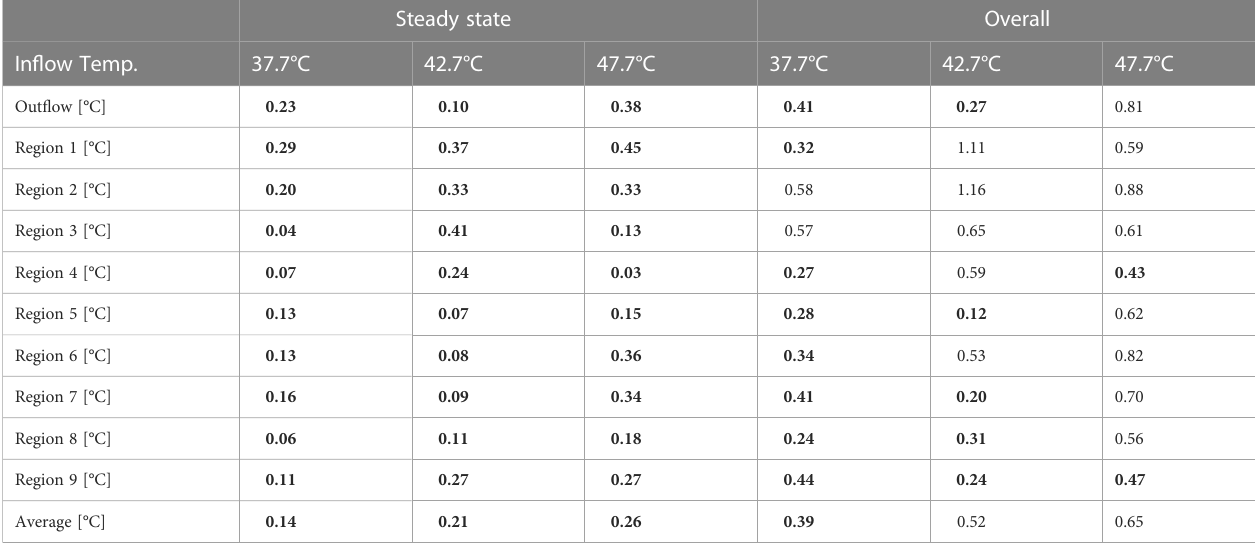
TABLE 5 Absolute errors between predicted an measured values for varying in fl ow temperatures (cases #1, #4 and #5). Steady state Overall In fl ow